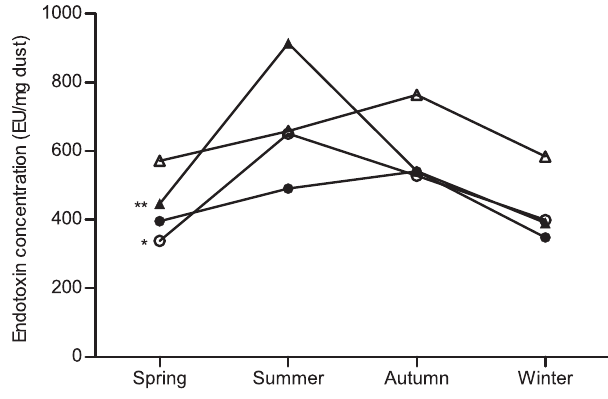
Figure 2. Seasonal variation of endotoxin concentrations in dust samples of children’s homes. N : asthma (AS) group; # : allergic rhinitis (AR) group; m : AS + AR group; n : control group. *: p , 0.05; **: p , 0.01.